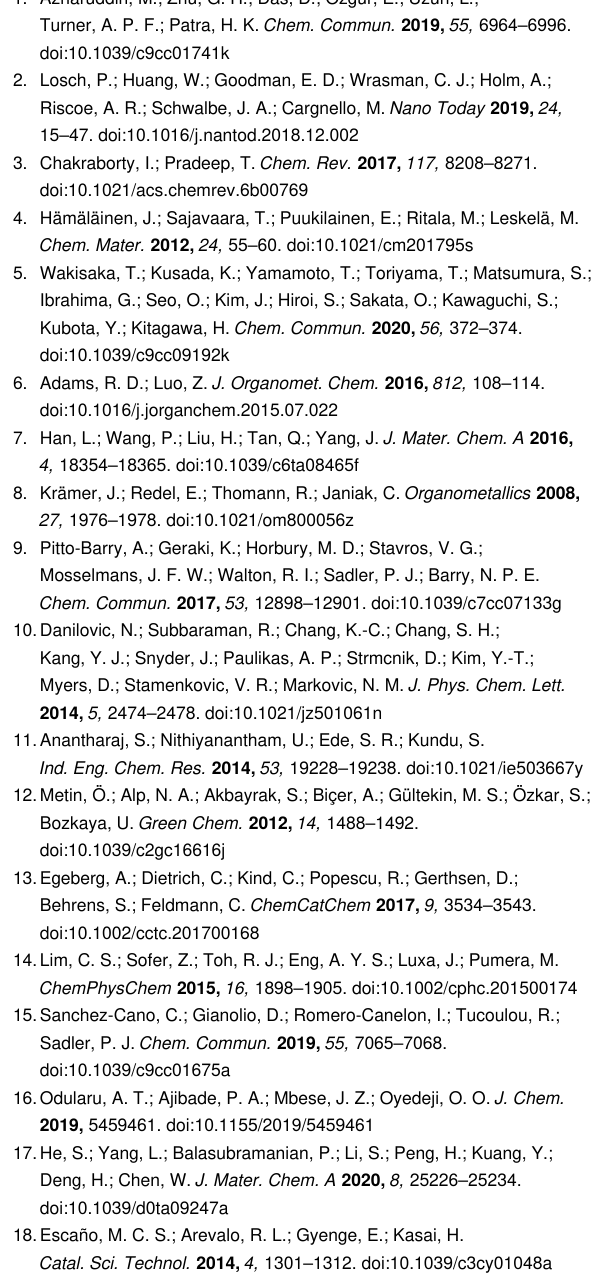
Figure S1: Literature survey on precious metals.